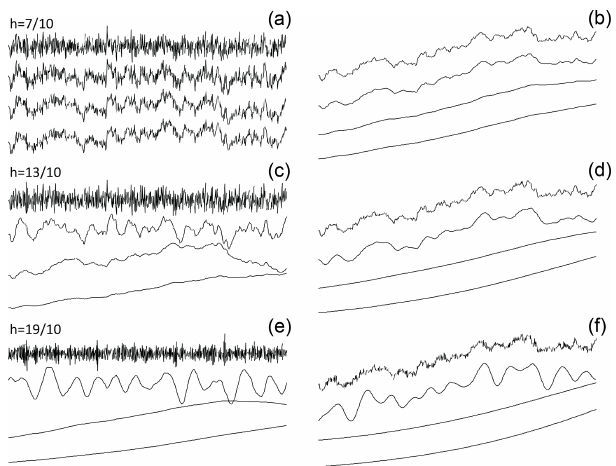
Figure 9. The same as Fig. 8 but for larger h values; see also Fig.